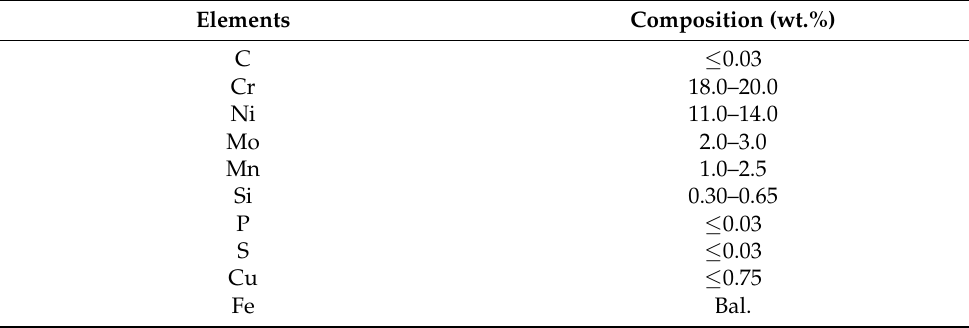
Table 1. Chemical composition of the SS 316L wire (in